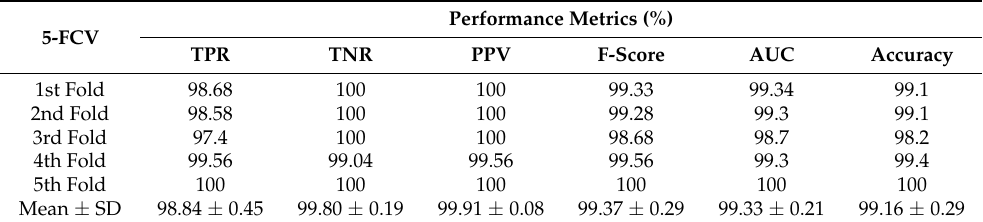
Table 7. Classification performance of the proposed model on Adamax optimizer.